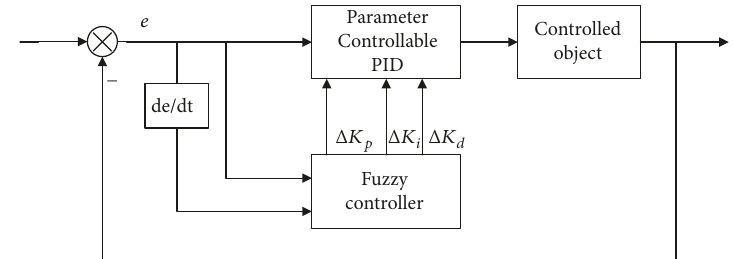
Figure 5: Fuzzy/PID compound controller structure.